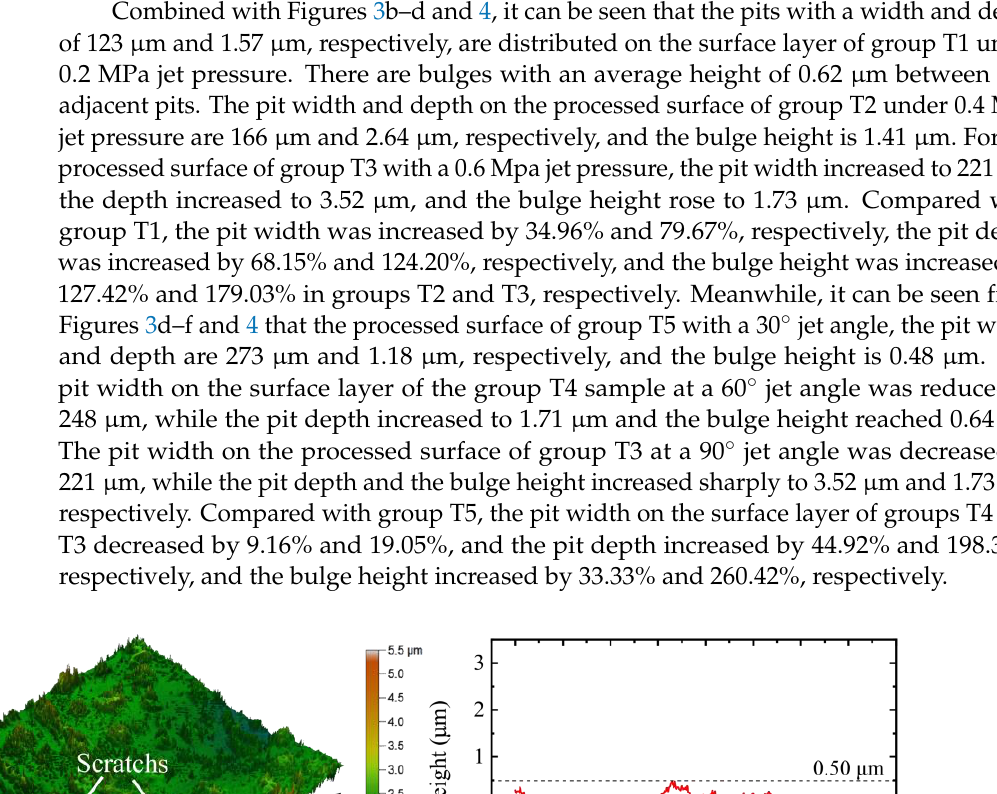
Figure 2. SEM micrograph of surface microstructure of samples. ( a ) control group T0; ( b ) group T1; ( c ) group T2; ( d ) group T3; ( e ) group T4; ( f ) group T5.